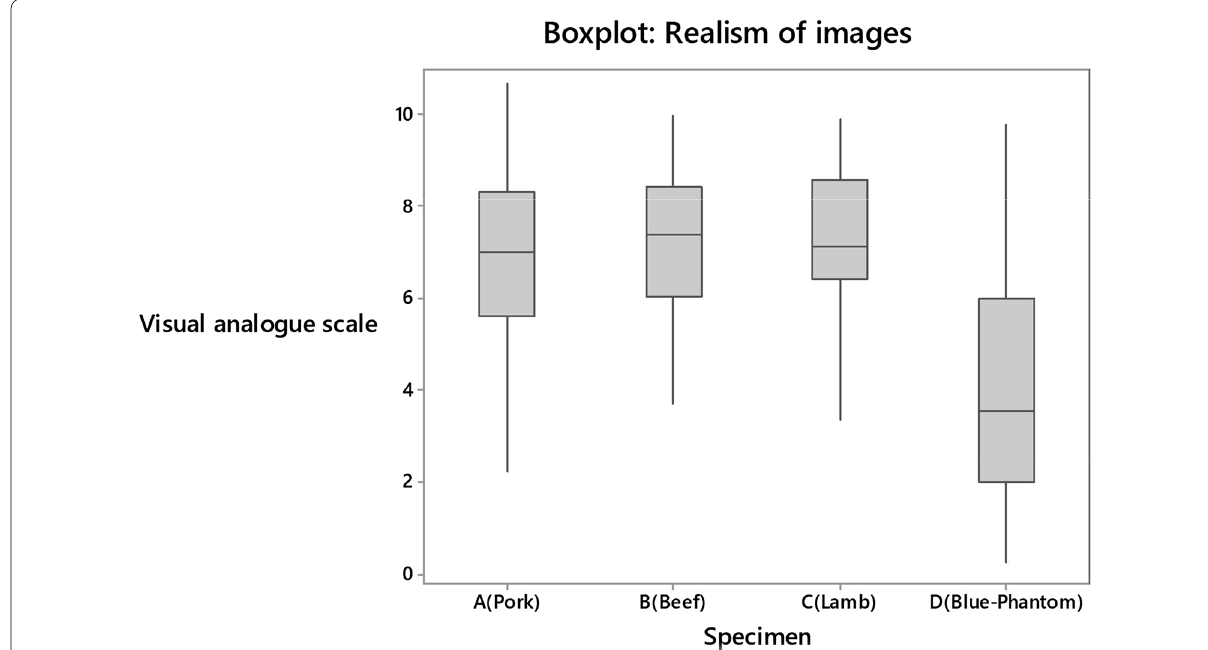
Fig. 3 Boxplot comparing the realism of the appearances of ultrasound images using a visual analogue scale (0 least like human tissue–10 most like human tissue)